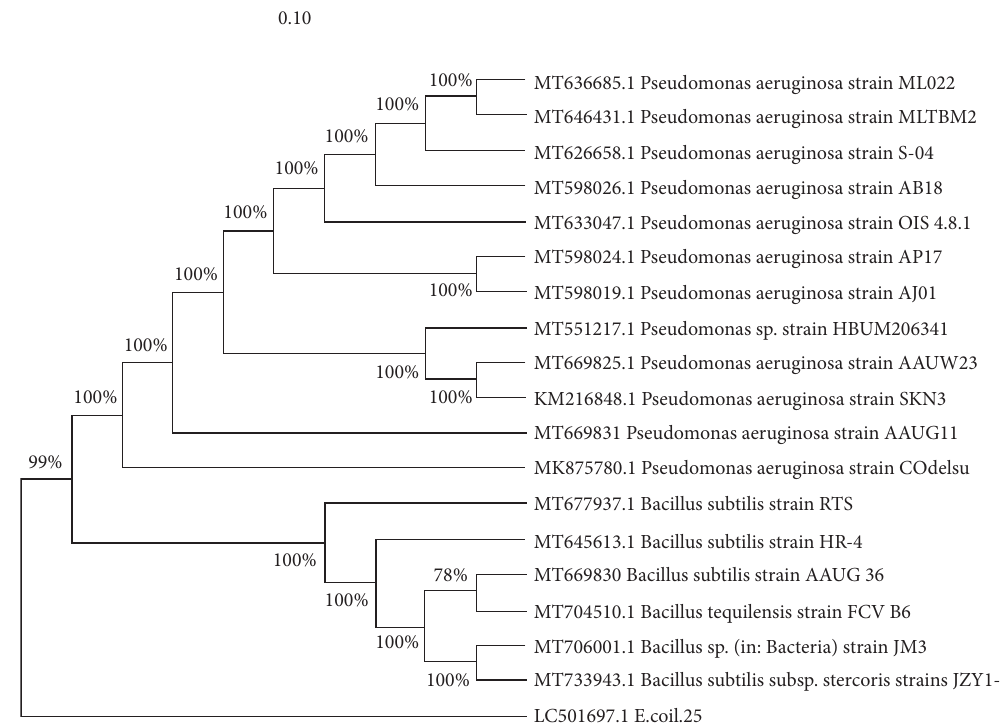
Figure 4: Phylogenetic tree based on partial bacterial sequences of the 16S rRNA region for the two Pseudomonas isolates and one Bacillus subtilis (bold and coded with the initials “AAU”) and accession numbers of the 16S rRNA are followed by species names. Numbers at nodes indicated bootstrap values for each node out of 1,000 bootstrap resembling. The phylogenetic tree was constructed in MEGA X using the maximum likelihood method [48] and Kimura-2 parameter model [32]. The Escherichia coli partial sequence was used as an